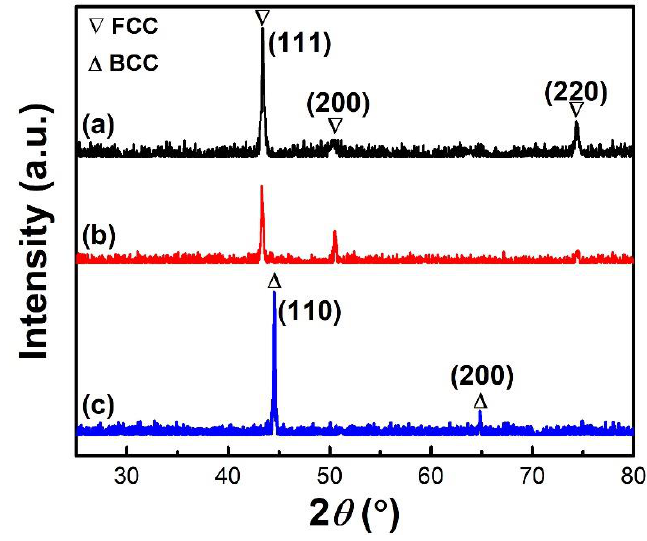
Figure 2. XRD patterns for base metal and powders: ( a ) as-annealed FeCoNiCrMn plate; ( b ) commercial FeCoNiCrMn powder; ( c ) commercial FeCoNiCrAl powder.